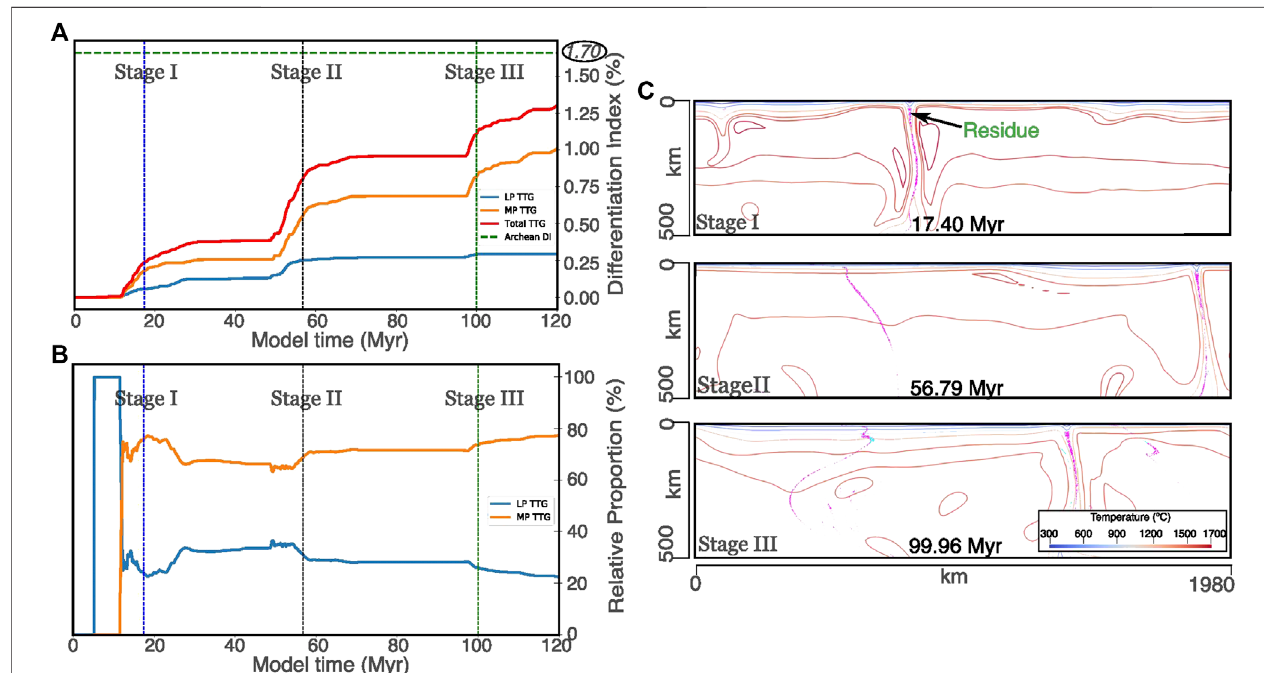
FIGURE5| Evolution of (A) thevolume oflow-Ptonalite-trondhjemite-granodiorite (TTG),medium-PTTGand totalTTGcrust [represented via DifferentiationIndex (DI)], and (B) the relative proportion of low-Pressure (LP) to medium-Pressure (MP) TTGs through model-time. The dashed green line in (A) represents the geologically constrainedDIvalue( ≥ 1.7)at3 Ga(termedasArcheanDI),correspondingtoacontinentalvolumeof70%ofitspresent-daypresent-value(seetextfordetails).Notethat Stage-I,II,andIIIrepresentthemajorchangesinthevolumeofTTGmeltsandtotalTTGcrust.Thesestagescorrespondto (C) thethreemajor,successivedripping phases in the model. The pink-coloured material represents the residue of the TTG melts. It must be noted that the residues form at shallow depths ( P < 2 GPa) where LP- and MP- TTGs are prescribed to form, and then they get transported to deep mantle owing to greater density. The relative proportions of LP-TTGs to MP-TTGs remain around the ∼ 1:3 ratio throughout the model (except during the initial, few million years), which agrees with the preserved igneous rock record.